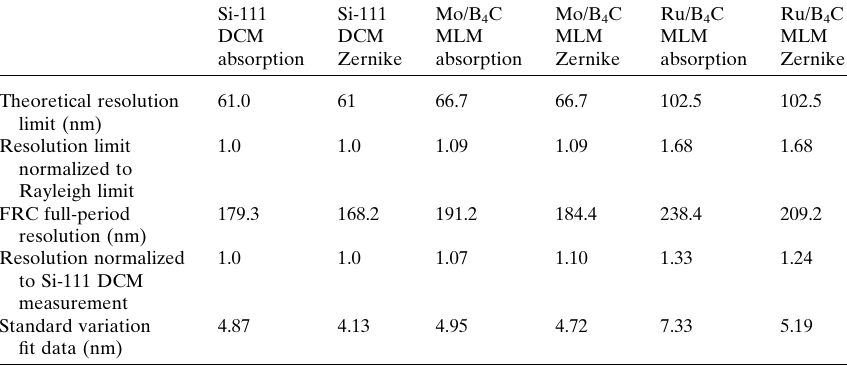
Table 5 The calculated resolutions from the FRC for the different energy bandwidths and contrast modes. The theoretical resolution limit has been calculated using the measured energy bandwidths discussed in the